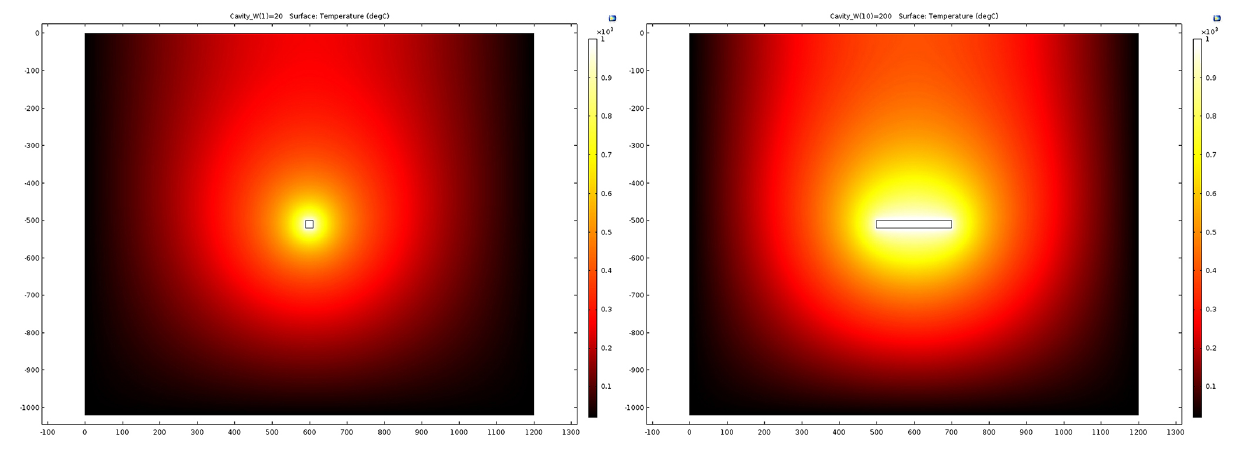
Figure 14. Temperature distribution around a medium seated cavity.